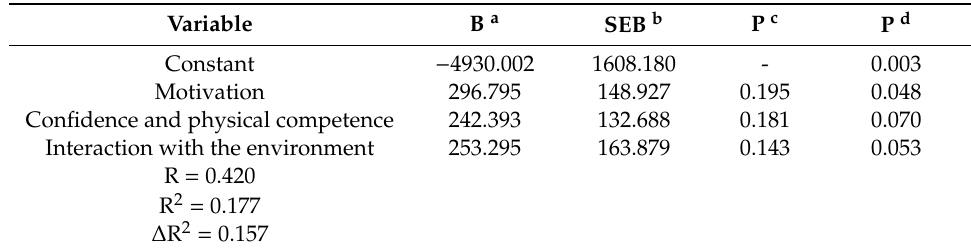
Table 3. Results of multiple linear regression analysis predicting PA level using perceived PL and its dimensions in males ( n = 133).